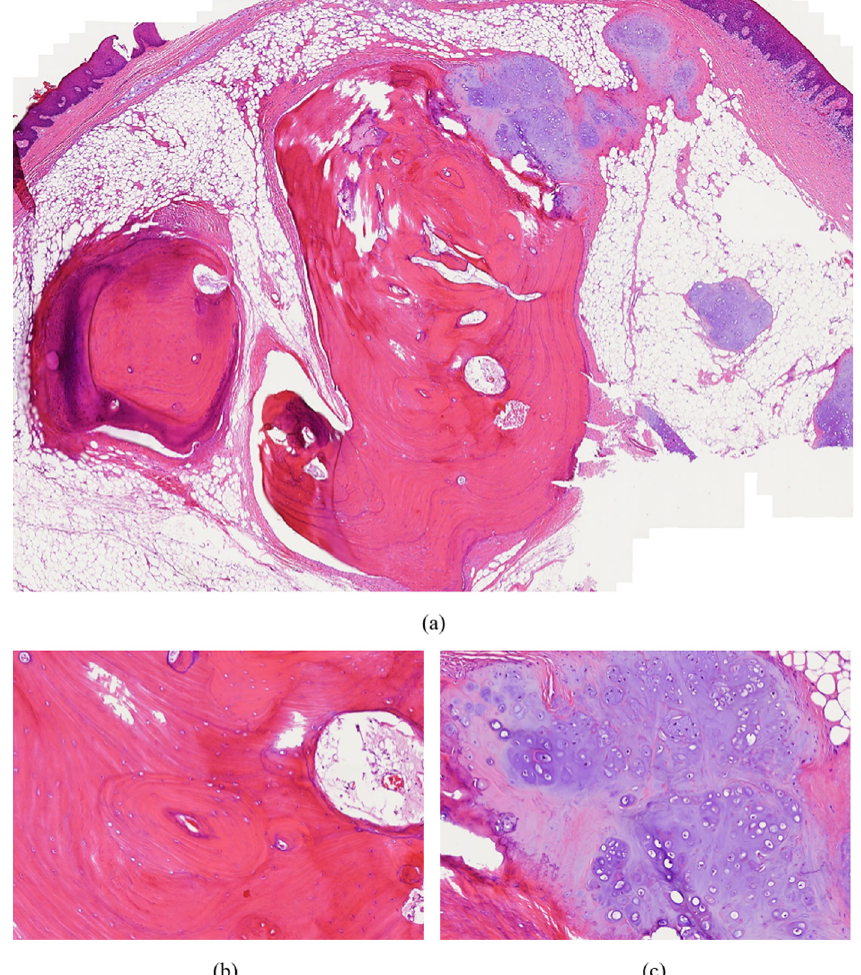
Fig. 3. Hematoxylin and eosin (H&E) stain of lipoosteocartilaginous choristoma of tongue. Low-power photomicrograph revealed multiple extensive calci fi cations resembling bone and cartilage within lamina propria surrounded by adipose tissue (a) (100 (cid:1) ); Higher magni fi cation showed osseous basophilic masses with characteristic rims of reversal lines and contains numerous lacunae with osteocytes (b); some areas of the outer periphery appear chondroid with the presence of mature hyaline cartilages containing lacunae with one to two chondrocytes noted (c) (b-c, 200 (cid:1)